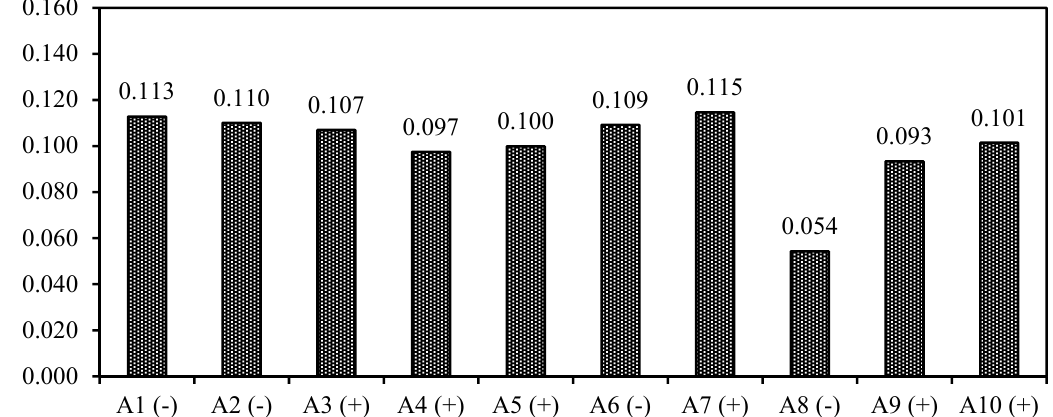
Figure 9. The final weights of the selected criteria in the group viewpoint.